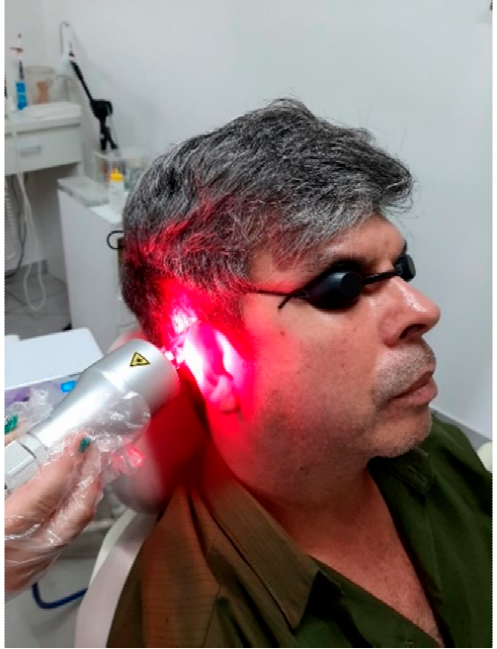
Figure 2. Device with suction cup and negative pressure combined with a cluster containing six LLLT outlets, three in red and three in infrared (VACUUMLASER, MMOPTICS, São Carlos–SP). Group 3 (n = 11): group treated with vacuum therapy, transcochlear LLLT for 6 min and fl unarizine dihydrochloride as a vasodilating drug. The same LLLT protocol as Group 2 was associated with Vertix ® ( fl unarizine dihydrochloride) with a dosage of 10 mg/day of fl unarizine (equivalent to 1 fl unarizine dihydrochloride tablet or 11.80 mg of fl